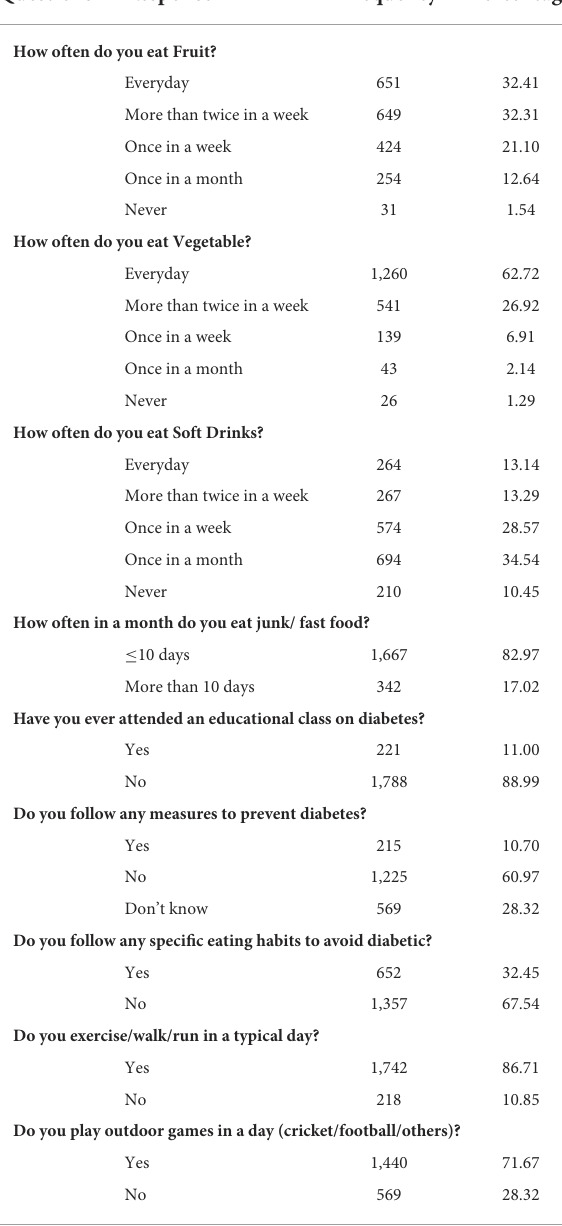
TABLE 4 Frequency distribution of the responses to practice